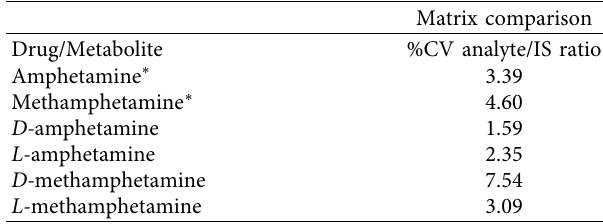
Table 2: Matrix efects 10 diferent lots of oral fuid were fortifed with QC material to a concentration of 7.5 ng/mL and the %CV determined of the analyte/IS area